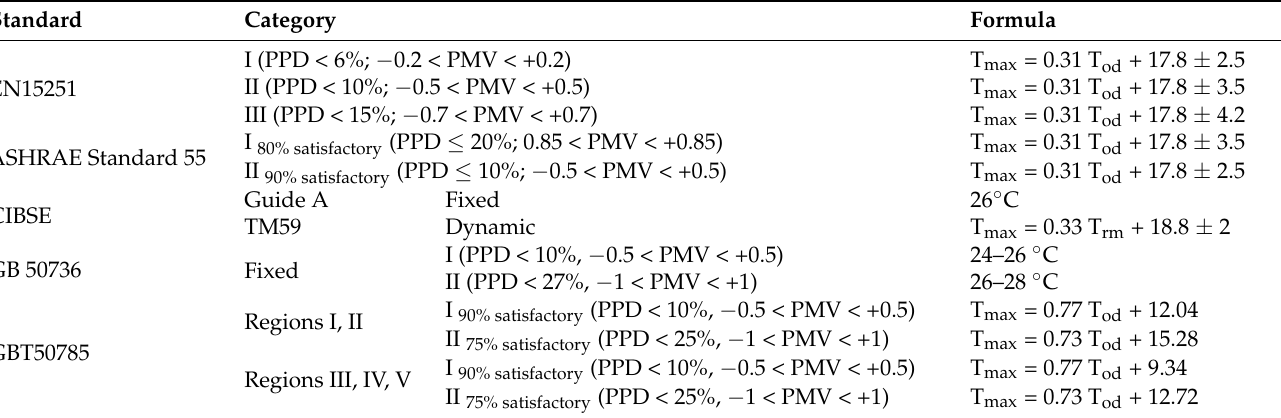
Table 1. Thermal comfort